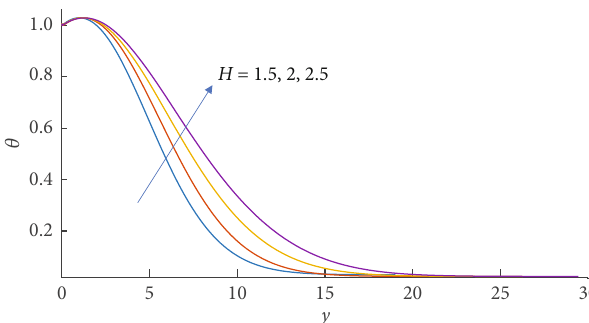
Figure 6: Increasing values of H for temperature fi eld when t = 0 : 2 , Pr = 6 : 2 , Ec = 0 : 1 , and F = 1 .